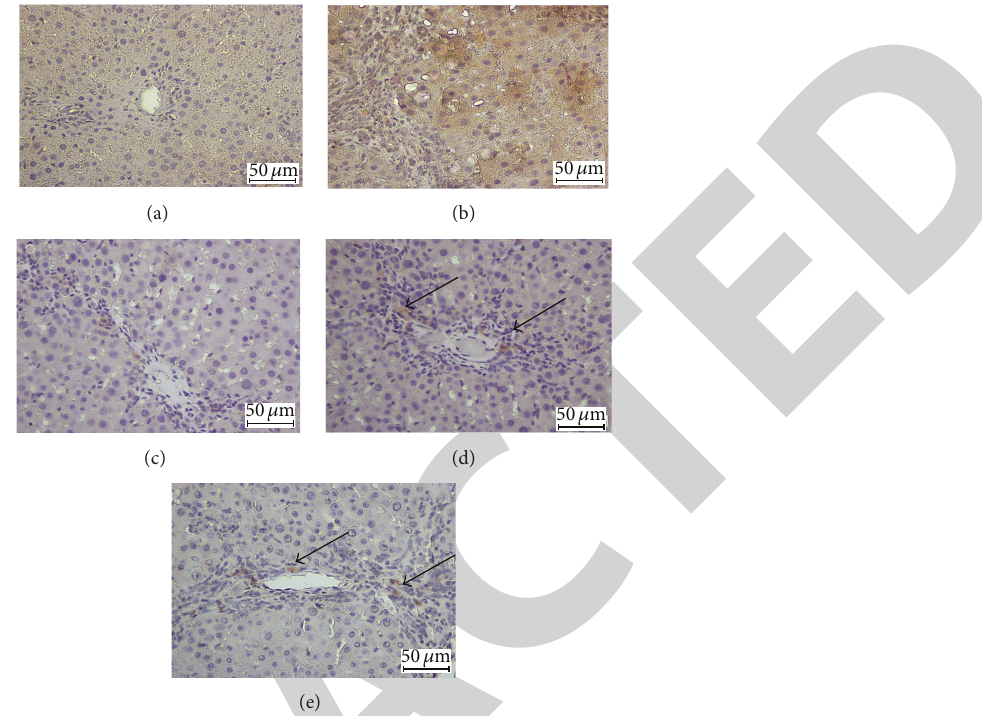
Figure 2: Photomicrographs showing immunohistochemistry staining of TGF- 𝛽 1 of livers from the different experimental groups. Control group: showing normal liver architecture, (b) TAA group (hepatotoxic group): showing more TGF- 𝛽 1 expression, (c) SY + TAA group: showing mild TGF- 𝛽 1-positive hepatocytes in the liver, (d) CS100 + TAA group: showing moderate TGF- 𝛽 1 expression, and (e) CS300 + TAA group: showing mild TGF- 𝛽 1 expression. (Bar scale: 50 𝜇